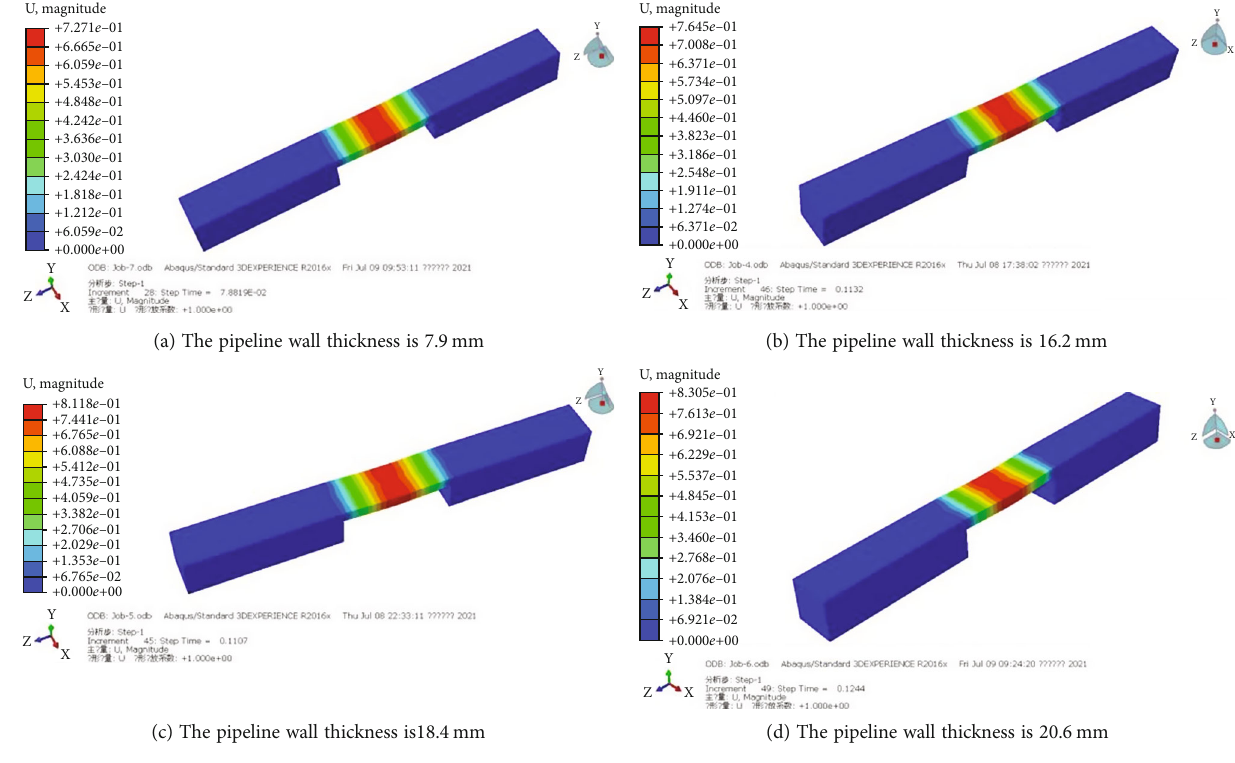
Figure 14: The soil displacement under di ff erent pipeline wall